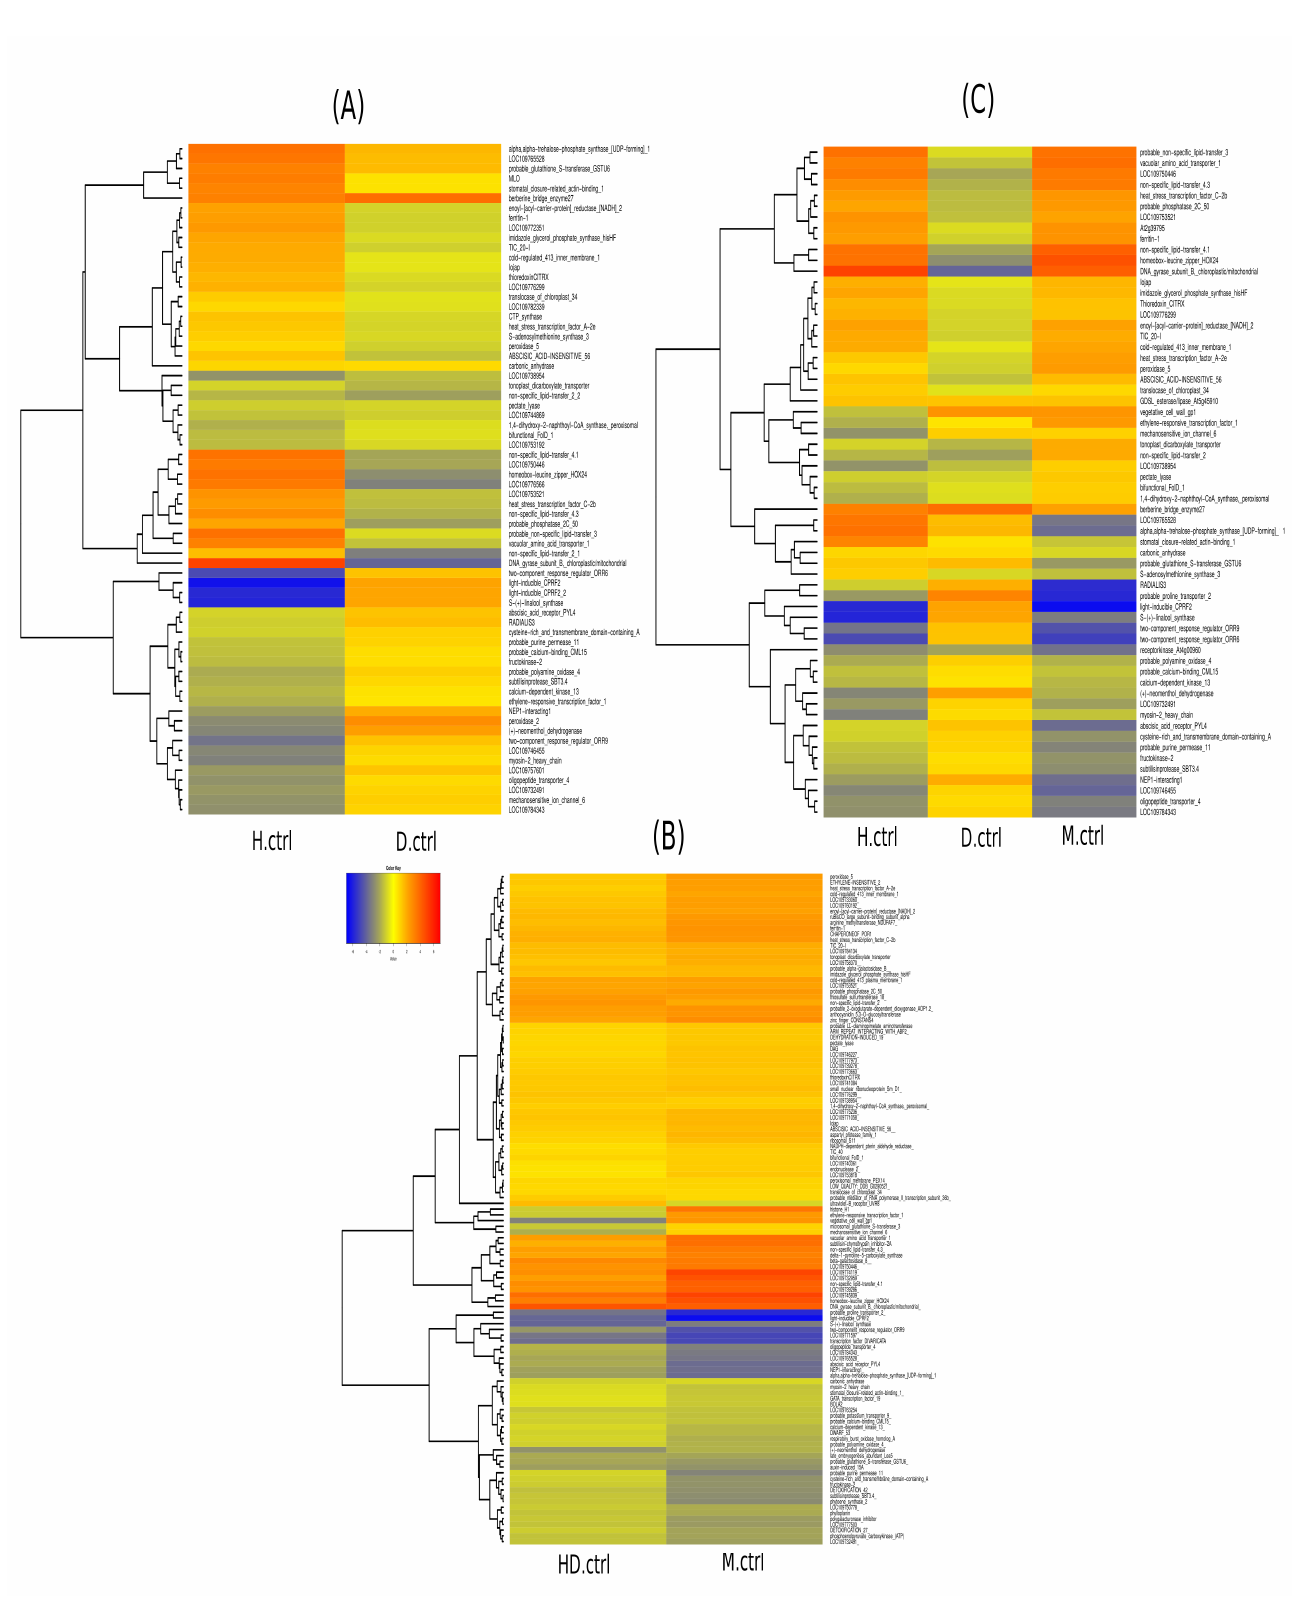
Figure 2. Heatmap and hierarchical clustering of di ff erential gene expression. The gene expression of shared genes between (A) H.ctrl and D.ctrl, (B) HD.ctrl and M.ctrl, and (C) H.ctrl, D.ctrl and